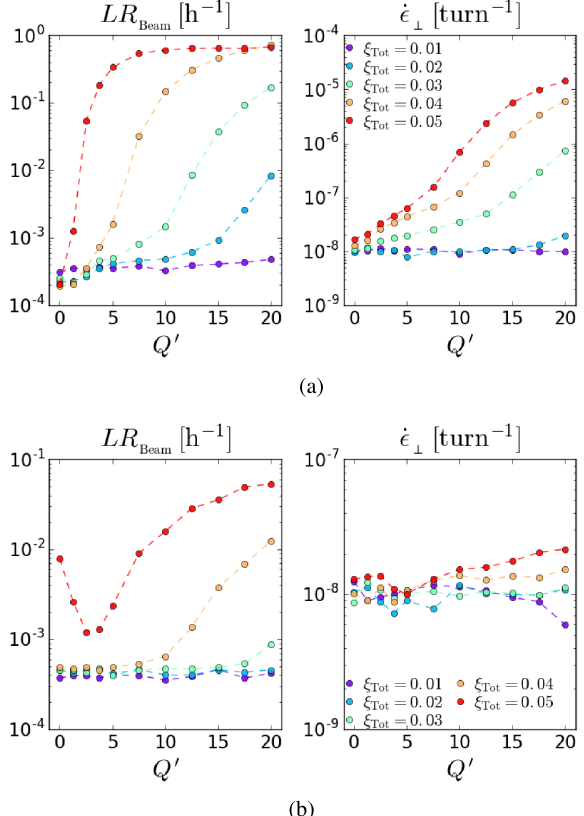
FIG. 20. Beam quality reduction for multiple combinations of FIG. 21. Beam quality reduction for multiple combinations of the chromaticity, Q 0 , and the beam-beam parameter, ξ , when the chromaticity, Q 0 , and the beam-beam parameter, ξ , when Tot Tot Q 0 . 31 , Q 0 . 32 . (a) β (cid:1) 4 m, ϕ 0 . (b) β (cid:1) Q 0 . 31 , Q 0 . 32 . (a) β (cid:1) 4 m, ϕ 1 . (b) β (cid:1) q ¼ q ¼ 12 cm, x ¼ y ¼ q ¼ q ¼ 12 cm, x ¼ y ¼ PIW ¼ PIW ¼ ϕ 0 . ϕ 1 PIW ¼ PIW ¼